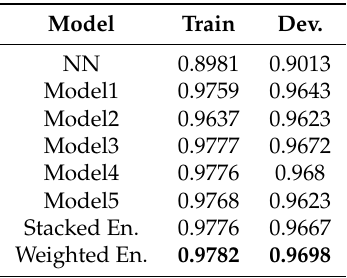
Table 3. Accuracy score for